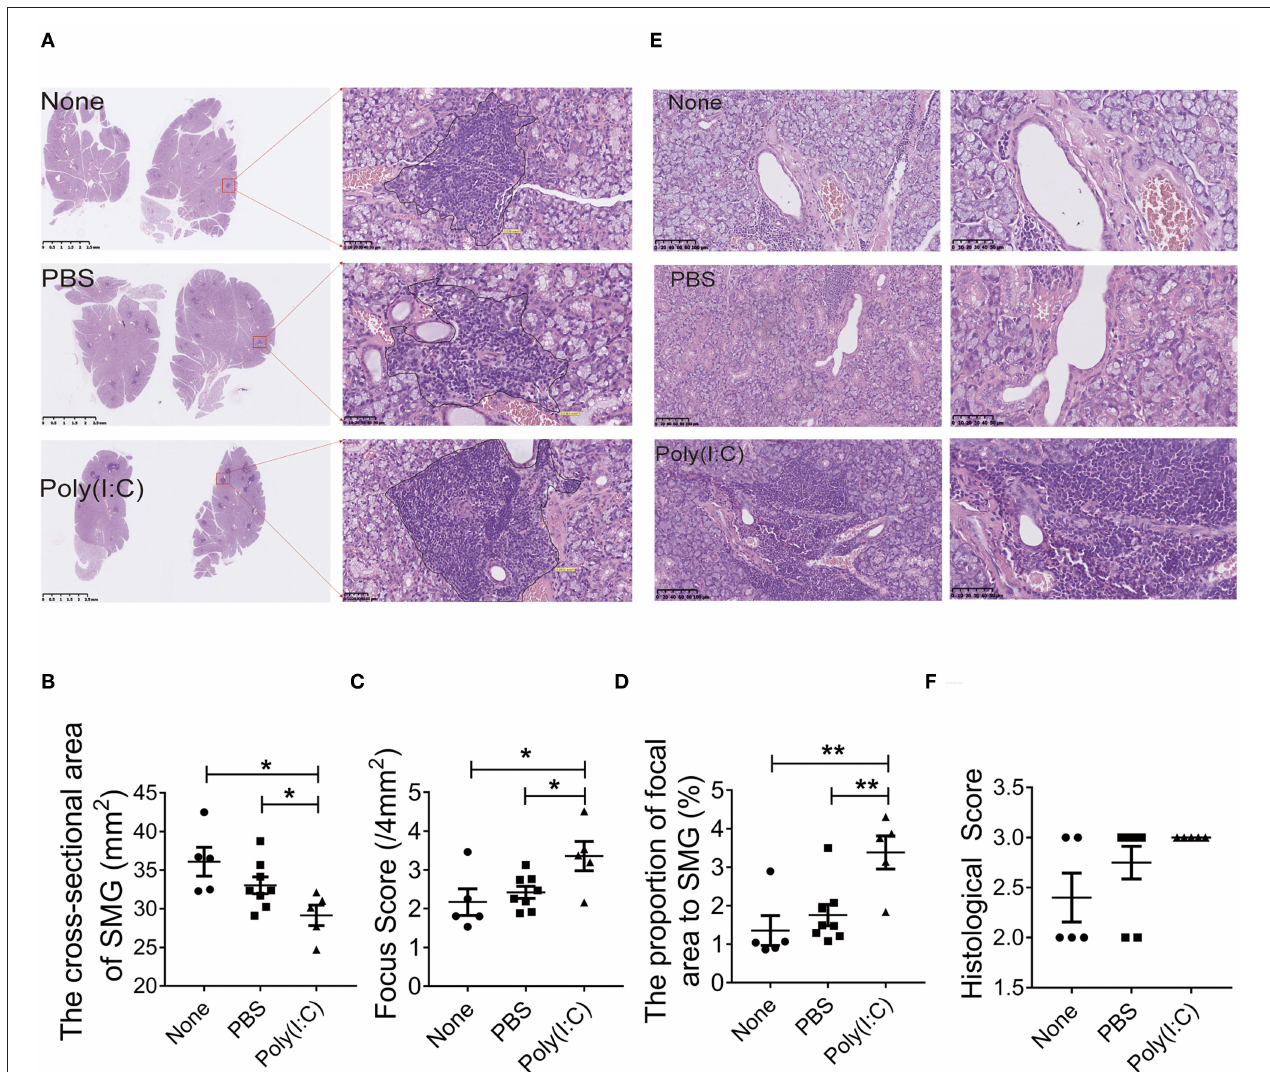
FIGURE 2 | Treatment with poly(I:C) aggravated the histopathological lesions of salivary gland. (A) Infiltrated lymphocyte foci in the acinar tissue of salivary gland in different groups (HE, × 10, × 400) ( n = 5–8 per group). (B) The analysis of the cross-sectional area of SMG in different groups. (C) The analysis of the focus score in different groups. (D) The analysis of the proportion of inflammatory cells area to the total salivary gland area in different groups. (E) Histological destruction of glandular duct (HE, × 100, × 200). (F) Histological destruction was assessed by a classification system with the proportion of the hyperplastic epithelium per square millimeter (mm 2 ). Data were presented as mean ± SEM, * p < 0.05, ** p <